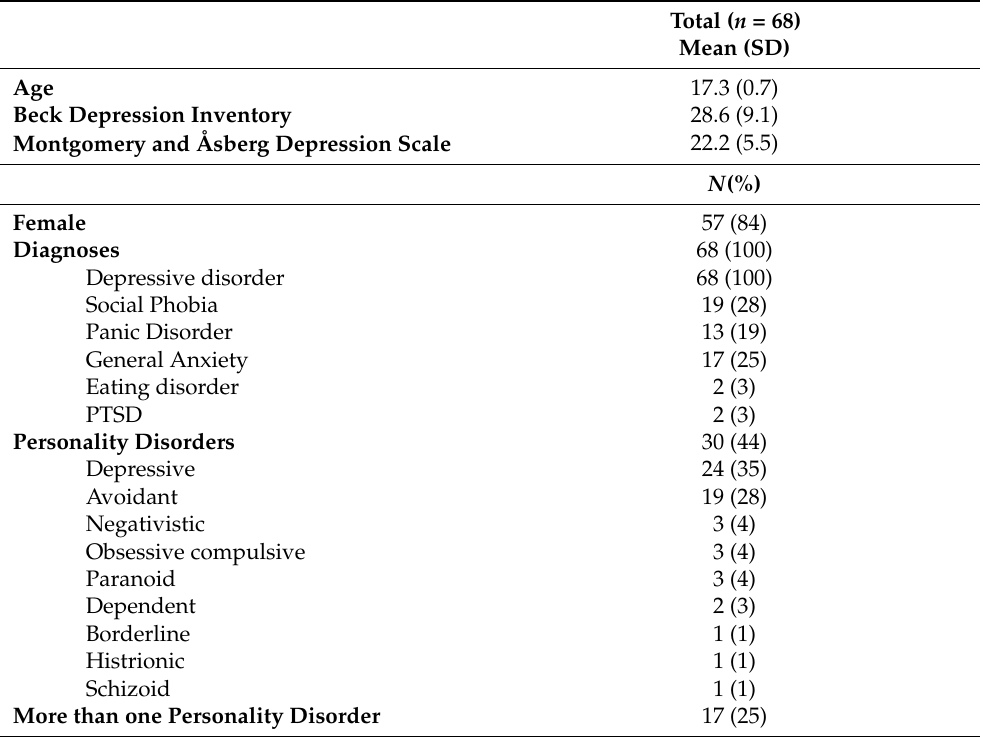
Table 1. The patients’ age, pre-treatment Beck Depression Inventory and Montgomery and Åsberg Depression Rating Scale scores. Diagnoses according to Mini International Neuropsychiatric Interview and Structured Interview for DSM-IV